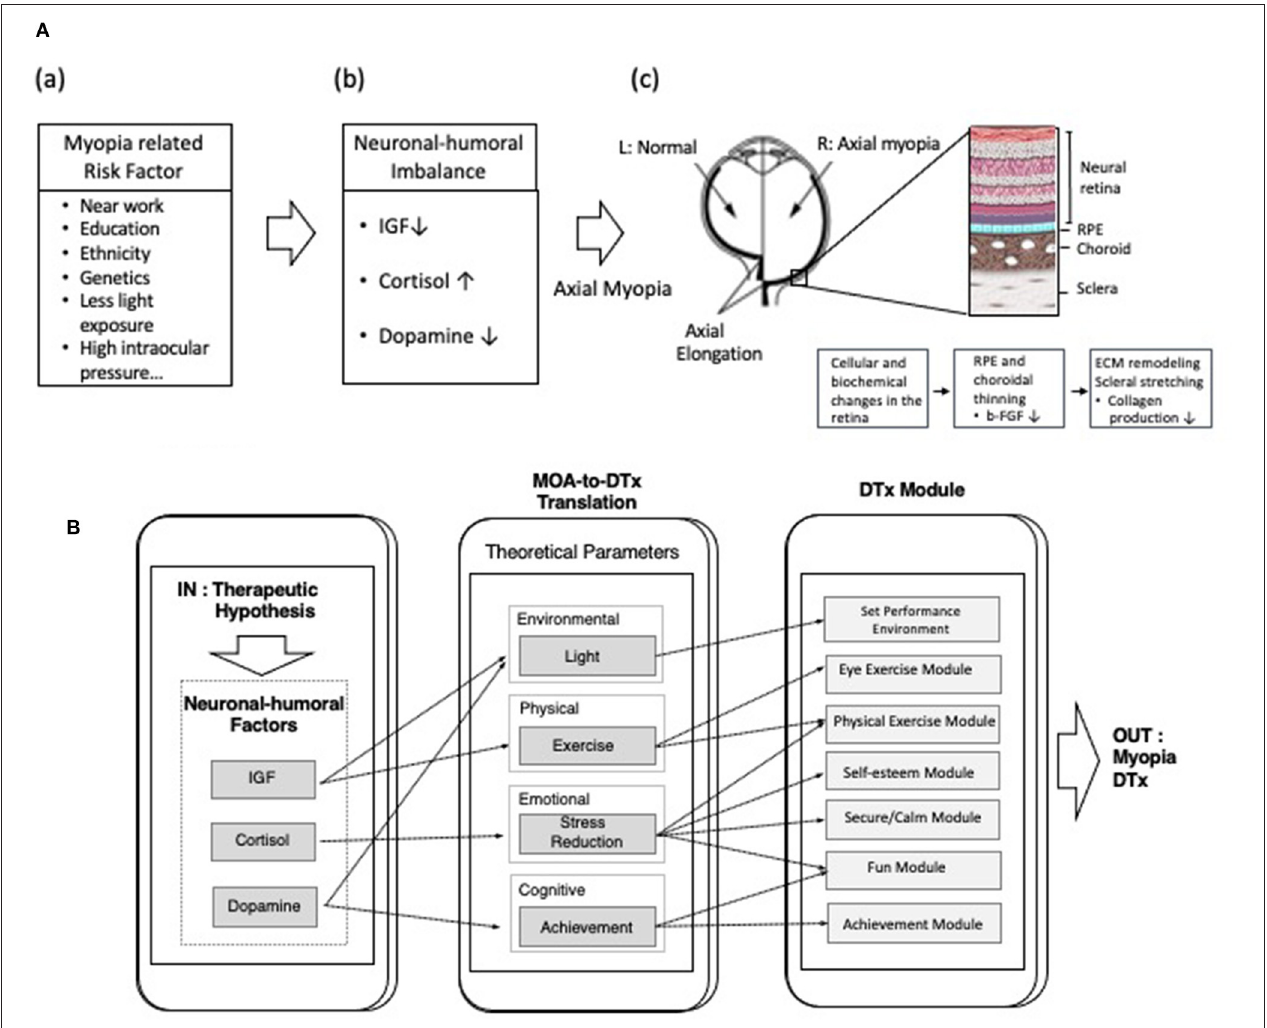
FIGURE 2 | (A) Schematic illustration of the hypothesis that imbalance in the level of neuronal–humoral factors (NHFs) affects axial elongation in pediatric myopia. (a) Various risk factors (near work, education, ethnicity, genetics, light exposure, and high intraocular pressure etc.) are known to cause myopia. (b) Imbalance of NHFs such as insulin-like growth factor (IGF), cortisol, or dopamine may affect the progression of axial myopia. (c) In axial myopia, vision begins to deteriorate as the axial length of the eye becomes greater than normal (axial elongation). During axial elongation, cellular and biochemical changes occur in eye’s posterior components, such as thinning of retinal pigment epithelium, choroid, and sclera. Disruption of cross linking of fibrils and fibers and reduction of the transverse cross-linking of collagen network in the sclera, leads to pathological stretching of choroid and sclera. (B) Schematic diagram of showing the level of neuronal–humoral factors regulated by corresponding theoretical parameters (environmental, physical, emotional, cognitive parameters), which are then translated into digital instruction. The outcome is novel digital therapeutics (DTx) for